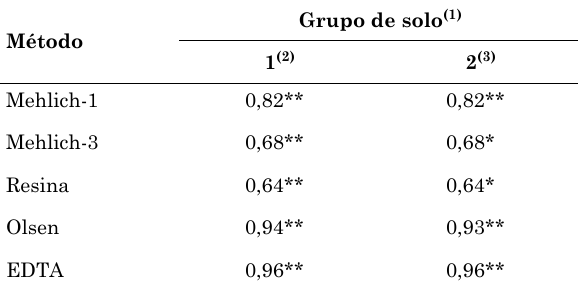
(1) Grupo de solo 1: Organossolo Háplico sáprico típico - Jaguaruna (OXs), Gleissolo Háplico tb distrófico típico - Itajaí (GXbd-I) e Cambissolo Háplico tb distrófico típico - Pouso Redondo (CXbd-P); e Grupo de solo 2: Gleissolo Háplico tb distrófico típico-Gaspar (GXbd-G) e Cambissolo Háplico tb distrófico típico-Itajaí (CXbd-I). (2) n = 12. (3) n = 8. * e **: significativos a 5 e 1 %,